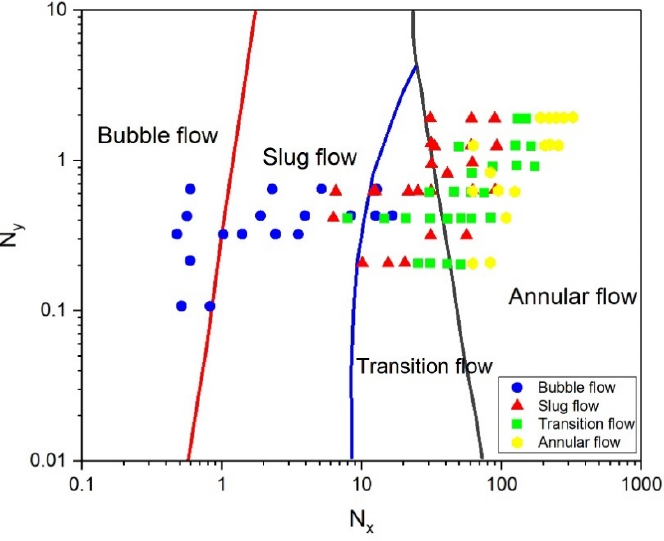
Figure 3. Application of different flow pattern discrimination formulae.